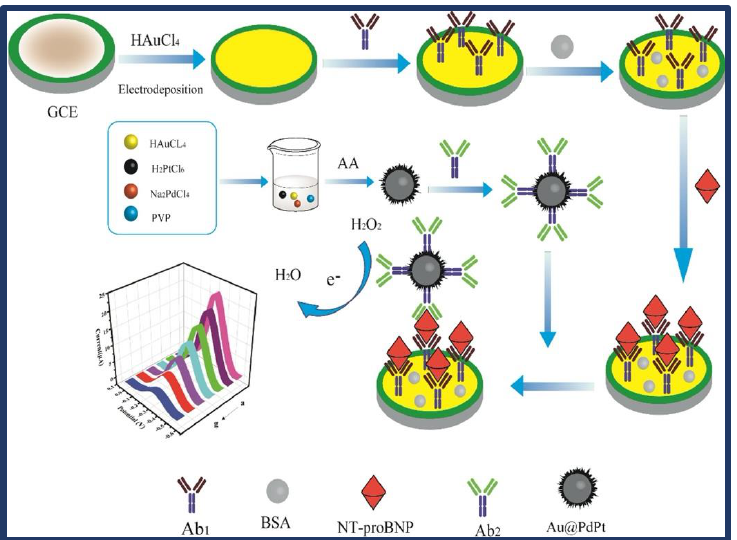
Figure 4. Diagrammatic representation of the sandwich electrochemical immunosensor preparation process. By square-wave voltammetry, the prepared electrode was scanned 0.0 V − 0.6 V in 10 mL PBS (pH 7.4) involving 5 mM H 2 O 2 . Reprinted from Ref. [45] with permission from Elsevier.